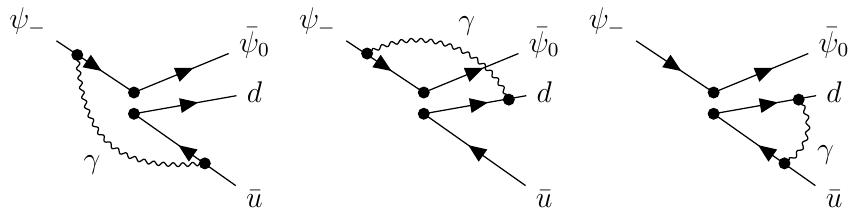
Figure 6 . The virtual corrections to the Wino decay into the free quarks in the Four-Fermi theory.